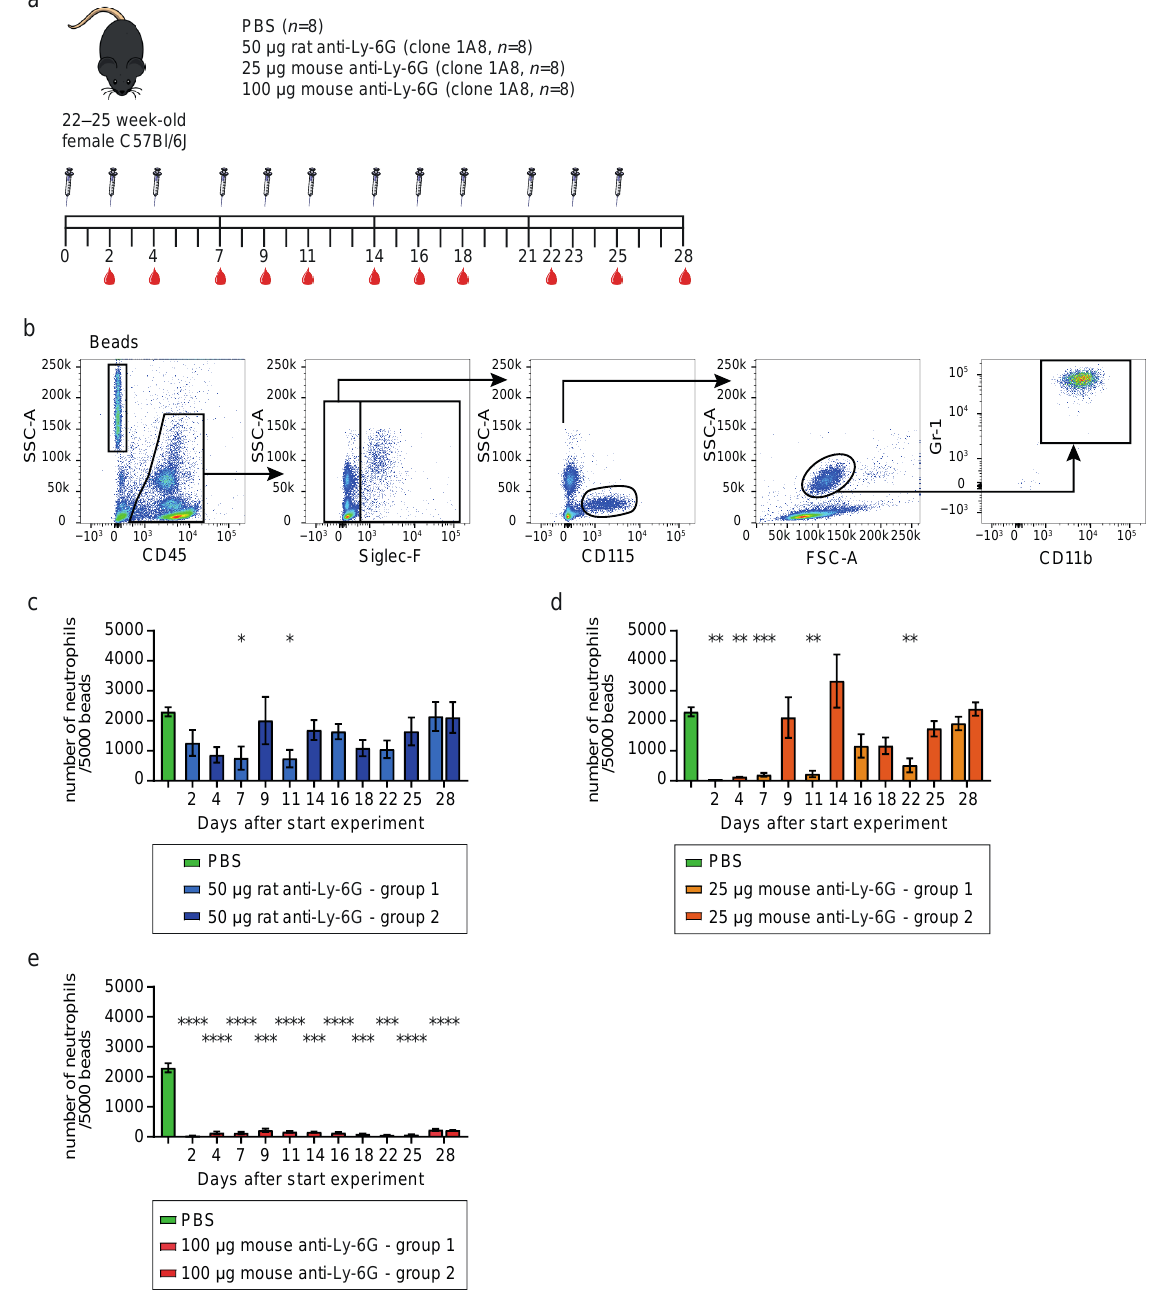
Figure 1. Mouse-Ly-6G efficiently depletes neutrophils in old C57Bl6/J mice. ( a ) Experimental set-up; i.p. injections with the depletion-antibodies or vehicle control (PBS) were performed three times